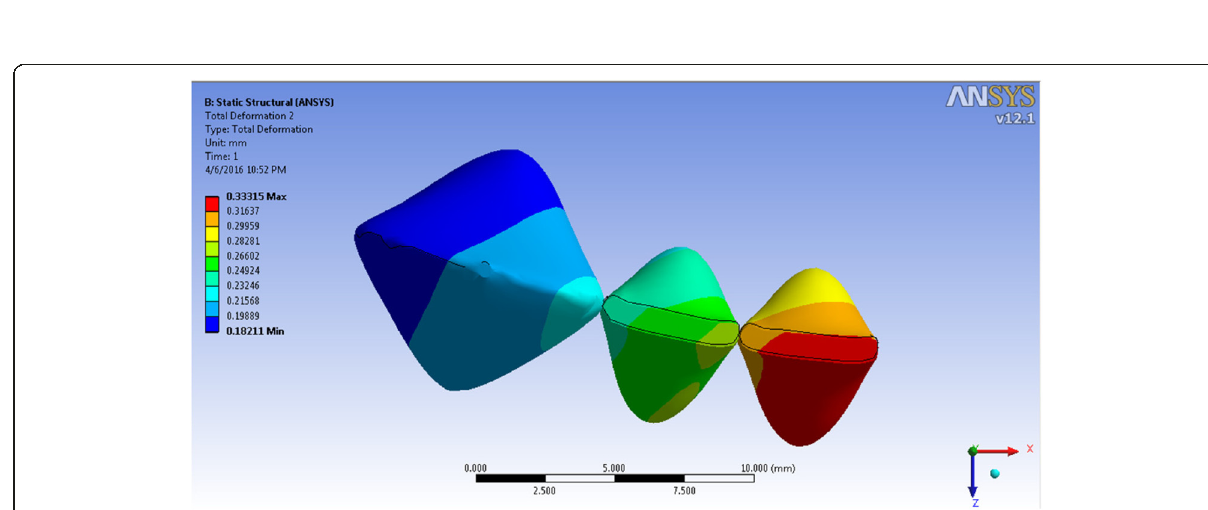
Fig. 6 Total deformation in the teeth of the second model (the inclination of the anterior teeth at 90° to the horizontal plane)